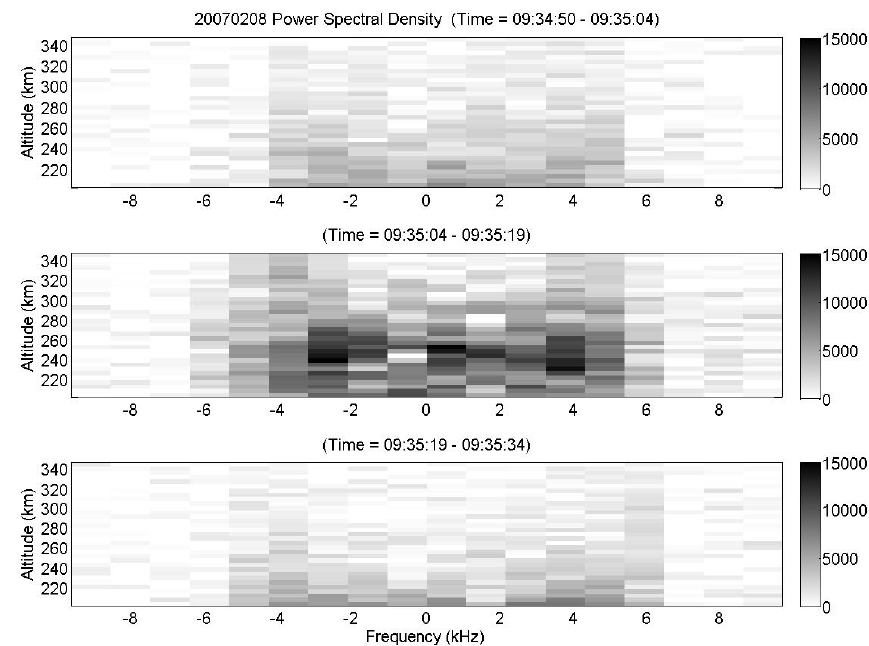
Fig. 2. The returned power as a function of altitude and frequency for 3 consecutive times, plotted with the same scale. (a) shows the time immediately before the NEIAL, (b) shows the time containing the NEIAL and (c) shows the time immediately after the NEIAL. These are also taken from the integrated data with 15s time